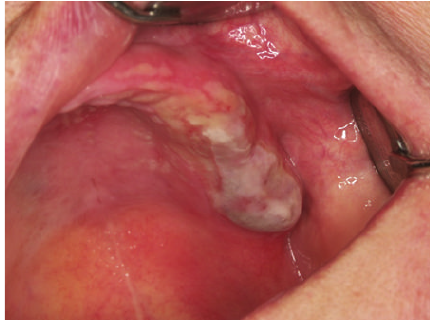
Figure 1: Oral lesion caused by Tinctura adstringens.